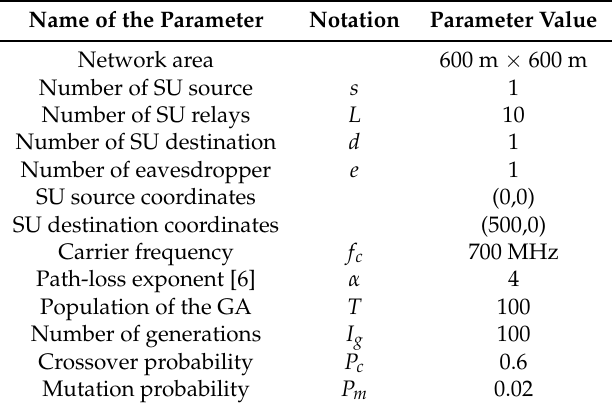
Table 1. Simulation parameters.